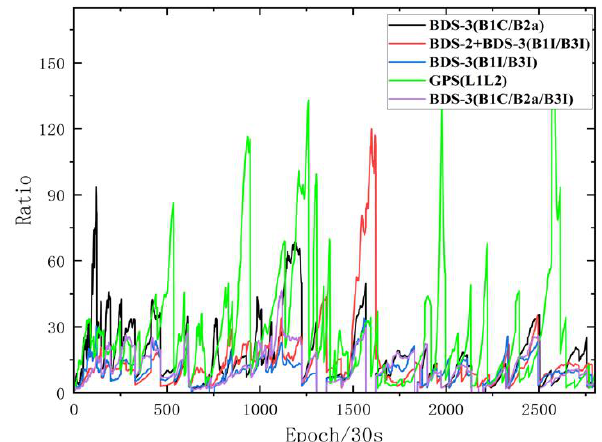
Figure 9. Ratio value variation of TGCU – TGBU (30 km).